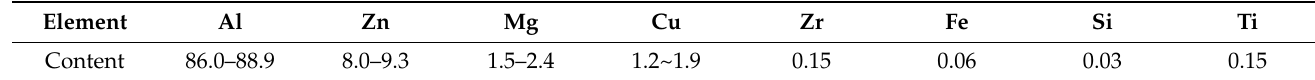
Table 1. Aluminum alloy composition (%, mass